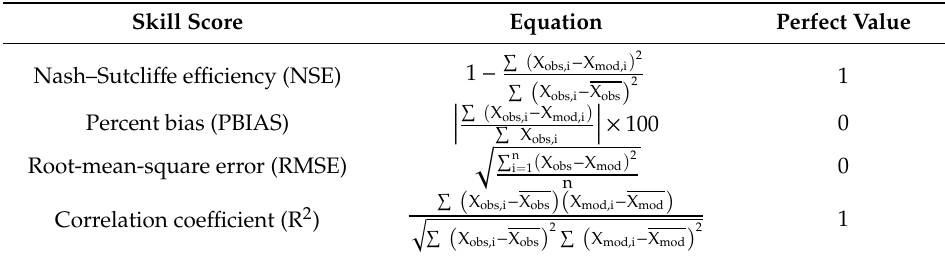
Table 1. Skill scores that are used in this